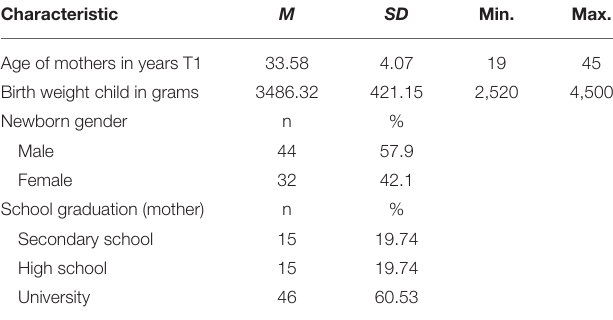
TABLE 2 | Characteristics of sample ( n =